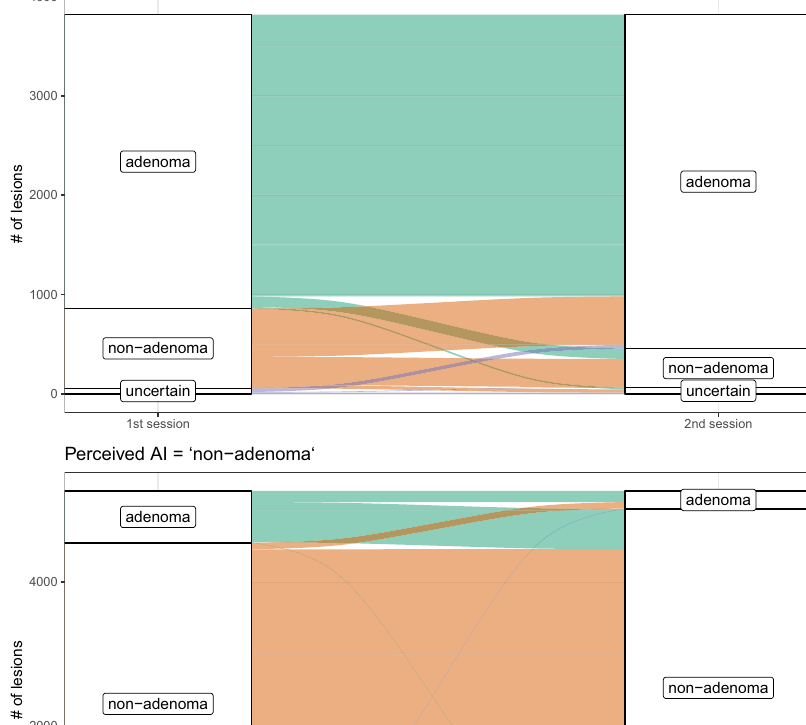
Effects of expertise. Endoscopists’ expertise modulated the variables considered for our main analyses. ai affected non-experts more than experts, and it had a larger impact on accuracy, possibly because experts’ had less to gain from ai’s added information since their accuracy was close to the ai accuracy. Furthermore, experts were less able than non-experts to discriminate between good and bad ai advice: both efficacy and safety are higher in non-experts than in experts (Table 5). The lower safety of experts seems at first counter-intuitive. However, it may be understood as a stronger preference of experts to avoid false-negative errors at the cost of